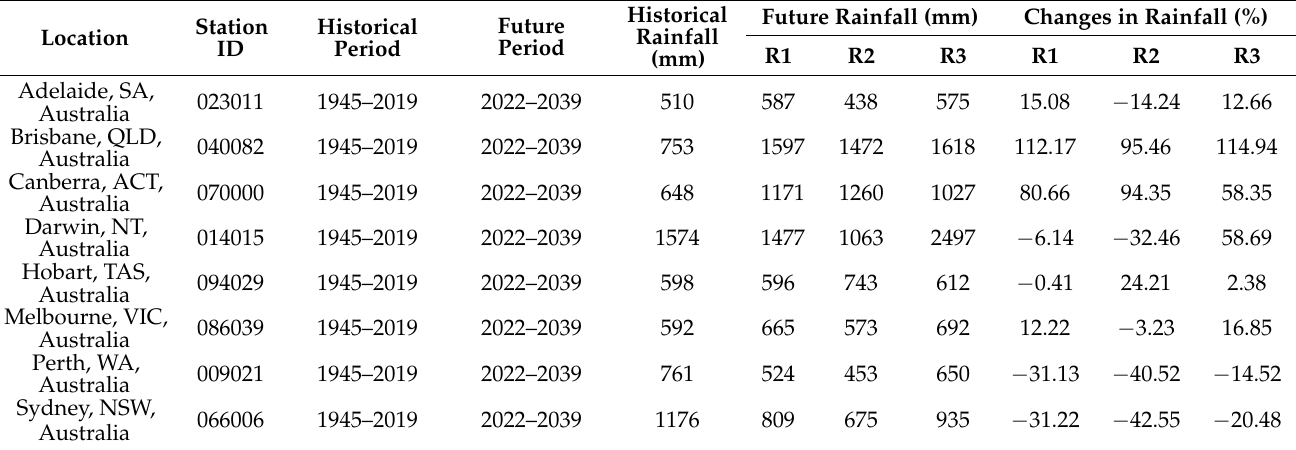
Figure 1. Location of the selected rainfall stations and spatial distribution of mean annual rainfall considering historical data. Table 1. Average annual rainfall changes at eight different